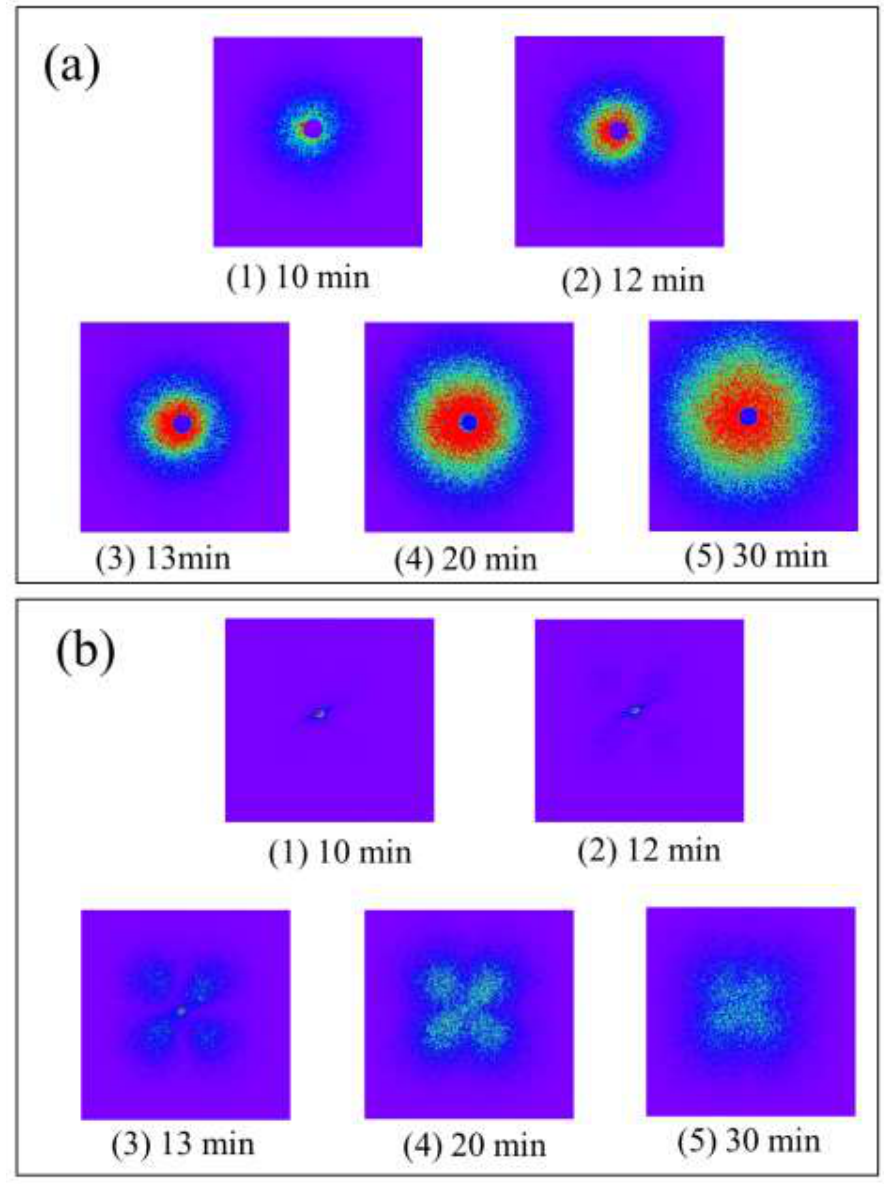
Figure 5. Series of light scattering images of α -spherulite of neat PVDF during isothermal crystallization at 165 °C: ( a ) Vv scattering; ( b ) Hv scattering.